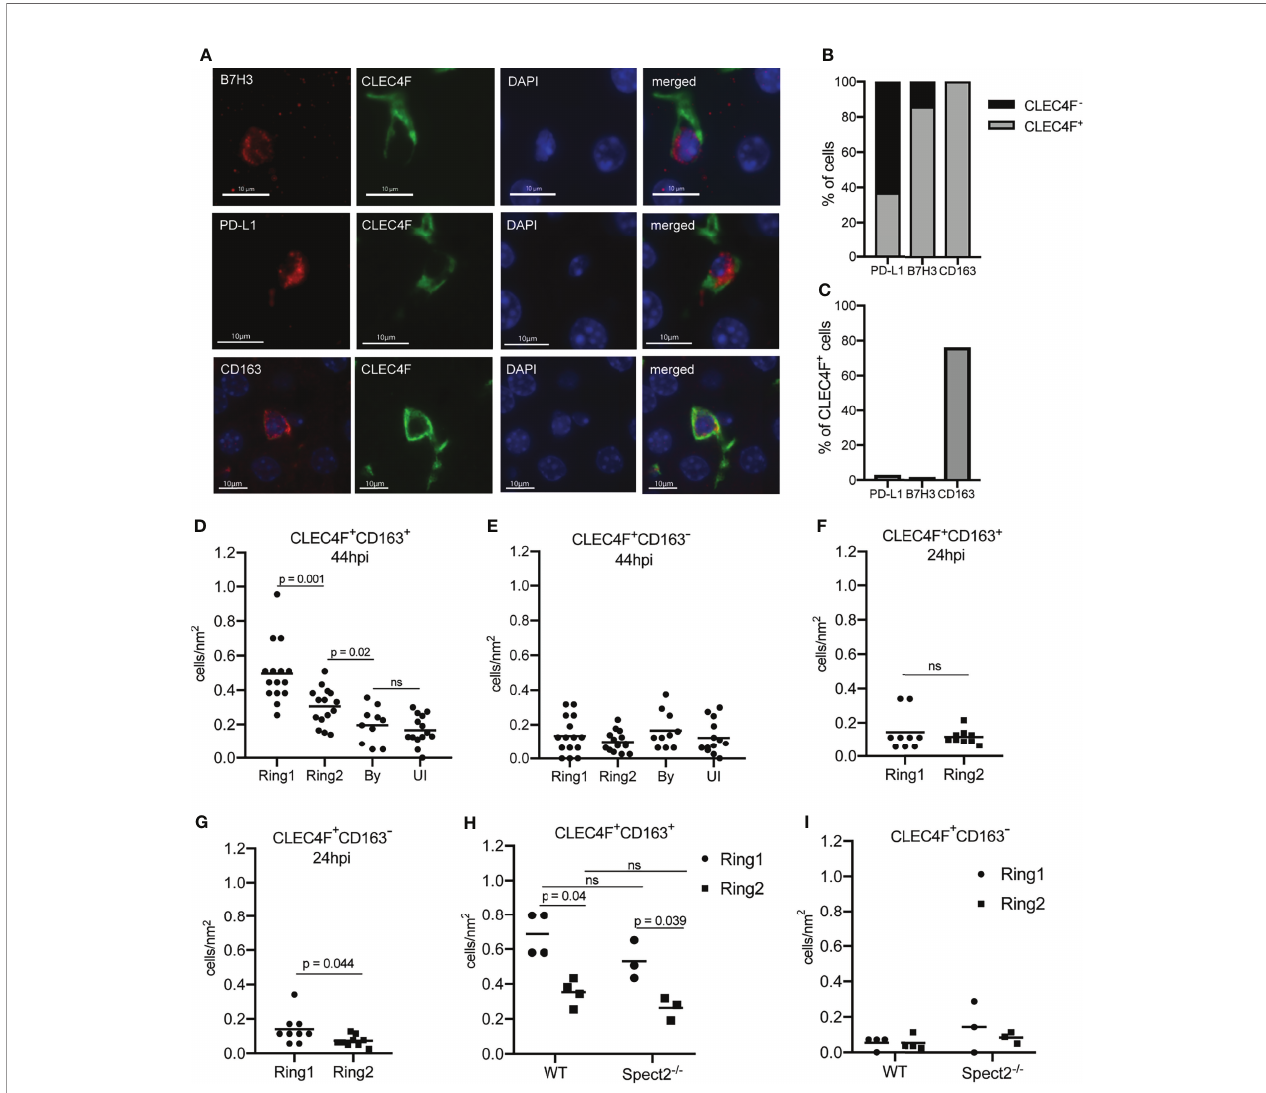
FIGURE 5 | Tolerogenic macrophages migrate to surround Plasmodium infected hepatocytes. (A) Representative images of fl uorescent staining of infected tissue for B7H3, PD-L1, and CD163. (B) Proportion of PD-L1 + , B7H3 + , and CD163 + cells within rings around infected cells that were CLEC4F + or CLEC4F - . (C) Proportion of CLEC4F+ cells within rings around infected cells that were PD-L1 + , B7H3 + , or CD163 + . (D) Number of CD163 + CLEC4F + and (E) CD163 - CLEC4F + cells normalized by area in Ring1, Ring2, bystander (By) tissue, and uninfected (UI) tissue at 44hpi. 3-6 matched ROI sets were counted from each of three mice. (F) Number of CD163 + CLEC4F + and (G) CD163 - CLEC4F + cells normalized by area at 24hpi. (H) Number of CD163 + CLEC4F + and (I) CD163 - CLEC4F + cells normalized by area, in Ring1 and Ring2 around wild type (WT) and Spect2 -/- parasites at 44hpi. ns, not signi fi